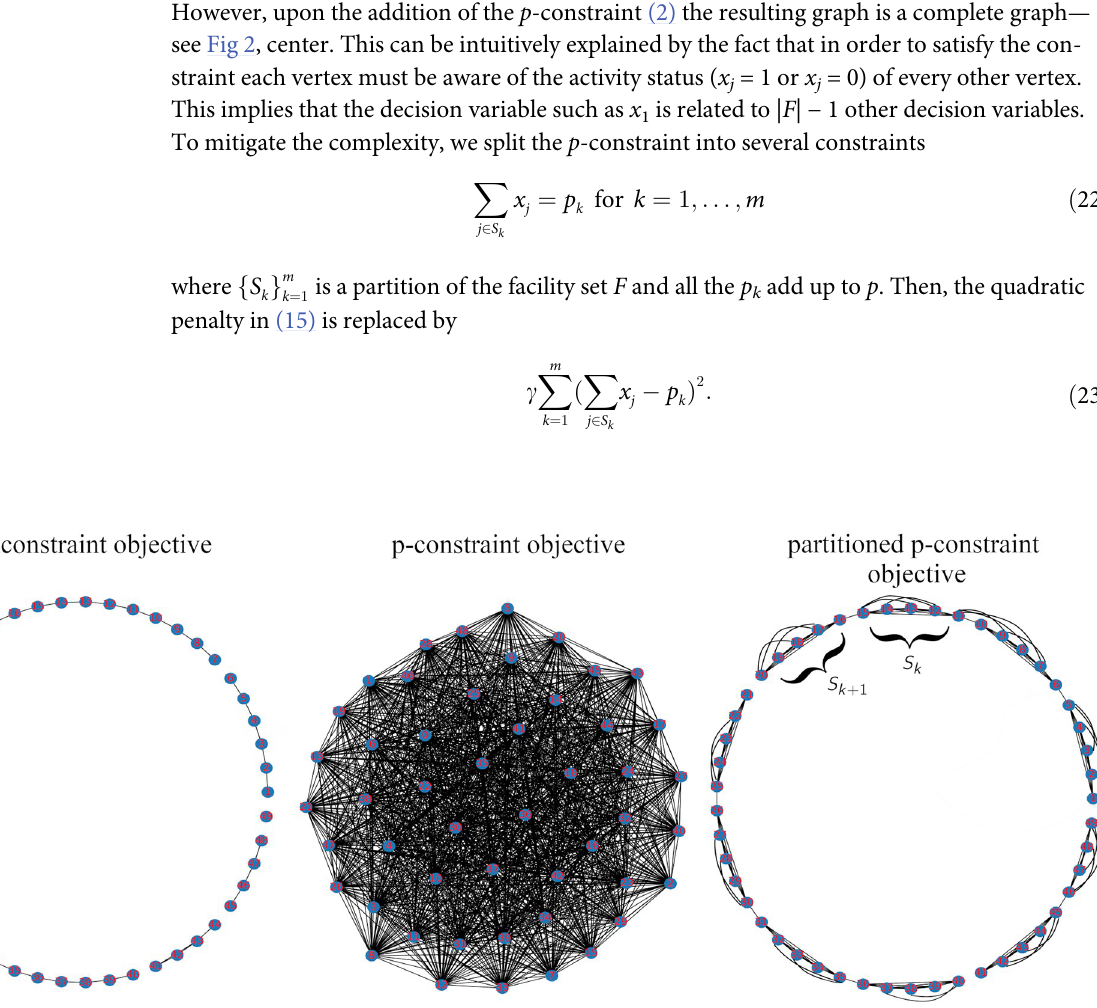
Fig 2. Graph networks depicting relations between 49 facilities under three different objective functions. Each vertex j 2 {1, ... , 49} represents the facility j , and each edge ( i , j ) represent competition between the facilities i and j . (Left) Inter-facility relations under the unconstrained quadratic objective (1). (Center) Objective function with the p -constraint added as a penalty (16). The resulting graph is dense because each facility must be aware of all other facilities. (Right) The objective function with the partitioned p -constraint as a penalty (24). The resulting graph is sparse because each facility must be aware of only facilities in the subset S k to which it belongs and its neighbouring